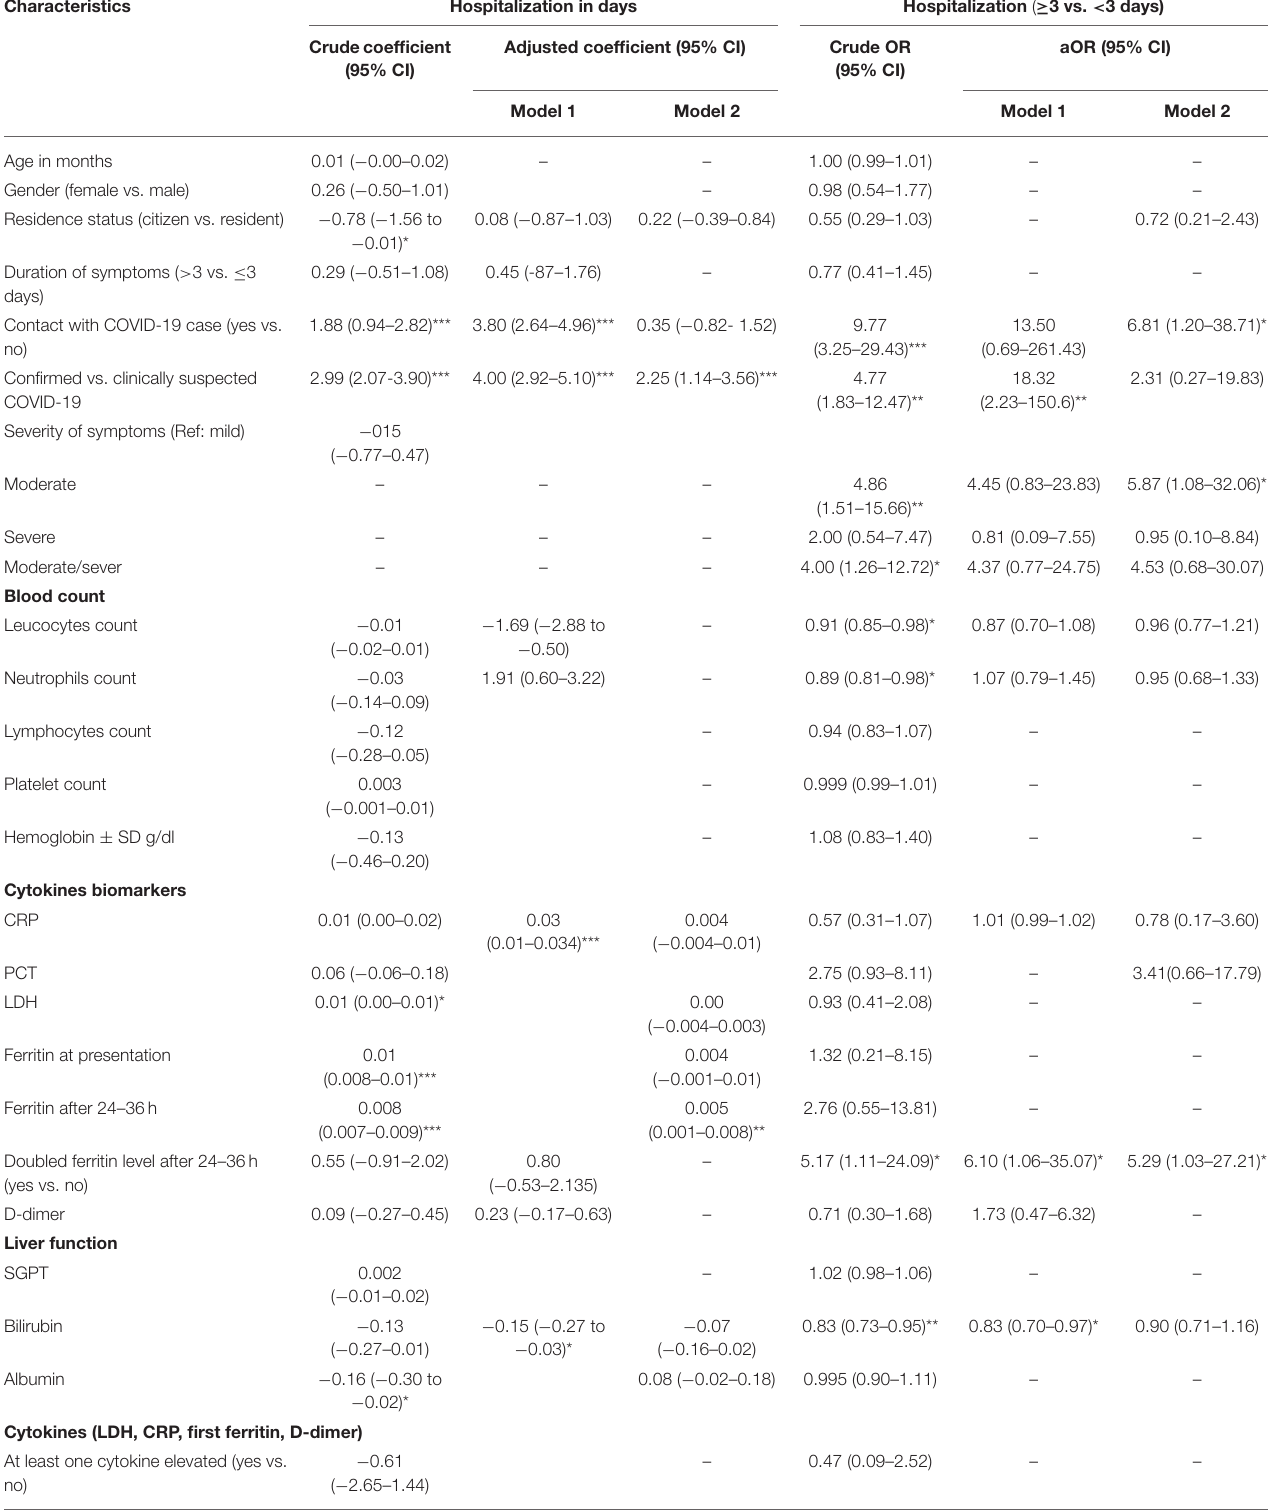
TABLE 5 | Bivariate and multivariate analysis of factors associated with duration of hospitalization among confirmed and clinically suspected COVID-19 pediatric